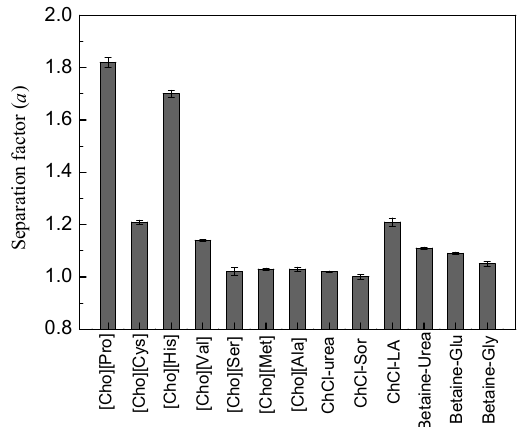
Figure 2. The separation factor ( α ) for different ATPSs composed of ChAAILs (or DESs) and K 3 PO 4 . The extraction conditions were as follow: 50 wt% ChAAILs (or DESs), 15 wt% K 3 PO 4 , 30 mmol/L HP- β -CD, 15 mg/mL phenylalanine. The experiments were performed at room temperature and without adjusting the system pH.